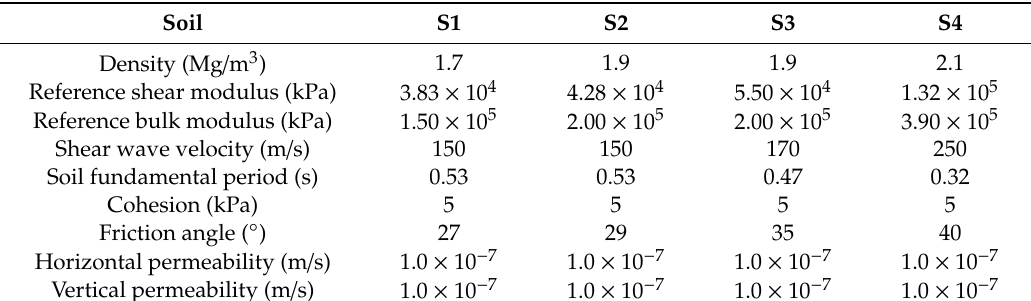
Table 1. Soil Table 1. Soil characteristics.